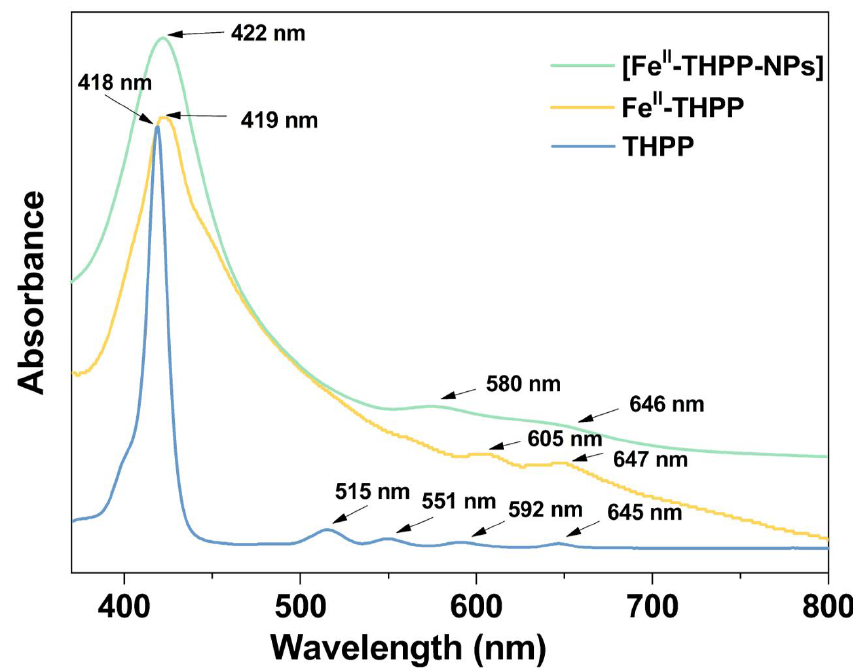
Figure 4. UV–Vis absorption spectra of the free-based ligand THPP (light blue), Fe II -THPP (light orange), and [Fe II -THPP-NPs] (light green) in MeOH solution.